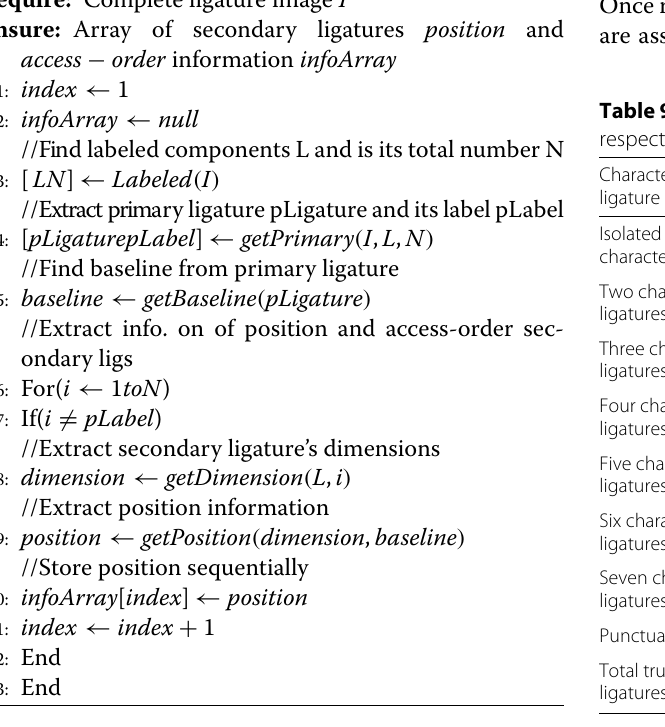
Algorithm 1 : Algorithm for secondary ligature’s position and access-order information retrieval